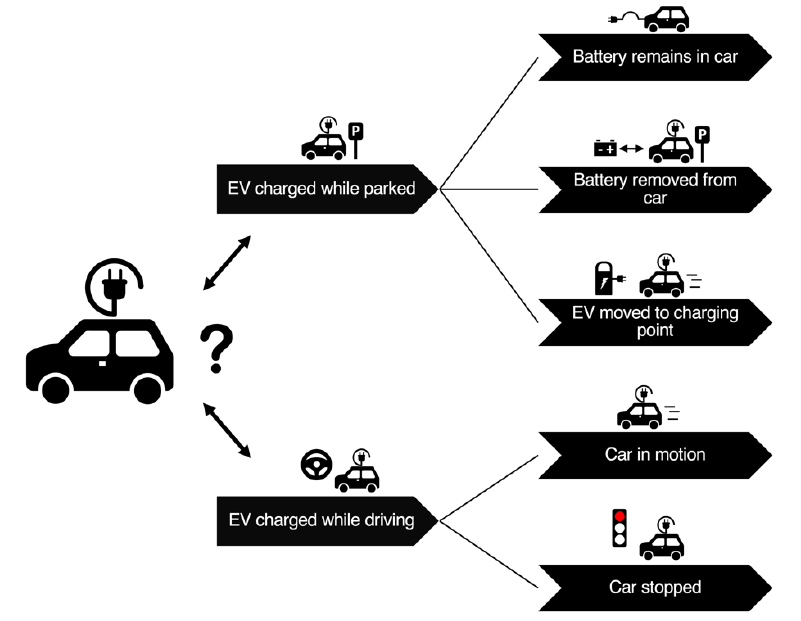
Figure 2. Lower tree structure of EV urban charging solutions. The full tree structure contains 2 additional branch levels (see Table